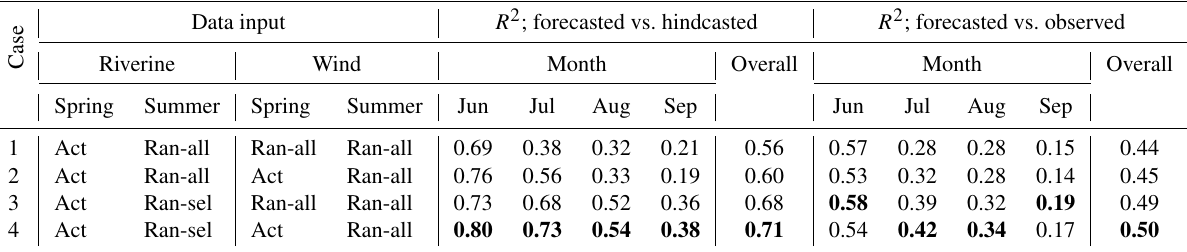
Table 2. Explained variance ( R 2 ) in hindcasted and geostatistically observed HA by pseudo-forecasts based on the different data input cases. Here, the term Act indicates actual data for the specific year being forecasted are used, Ran-all indicates that input data are randomly sampled from the complete historical record, and Ran-sel indicates that riverine input data are randomly sampled from a subset of relevant historical years based on the regression projections for flow and loading. Spring includes March–May, while summer includes June–September records. The highest R 2 values for each month are highlighted in